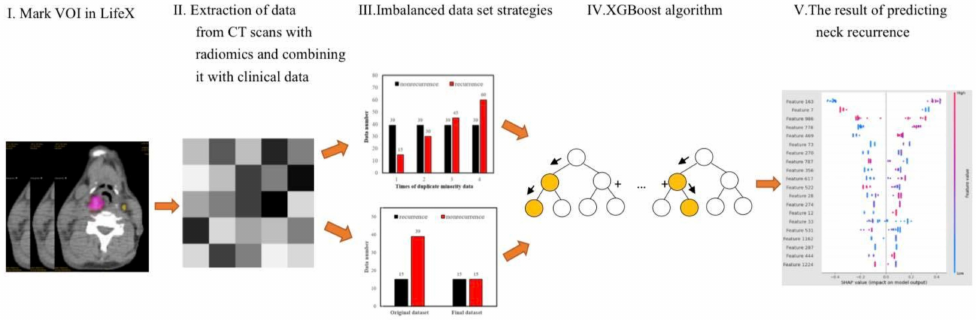
Figure 1. The study